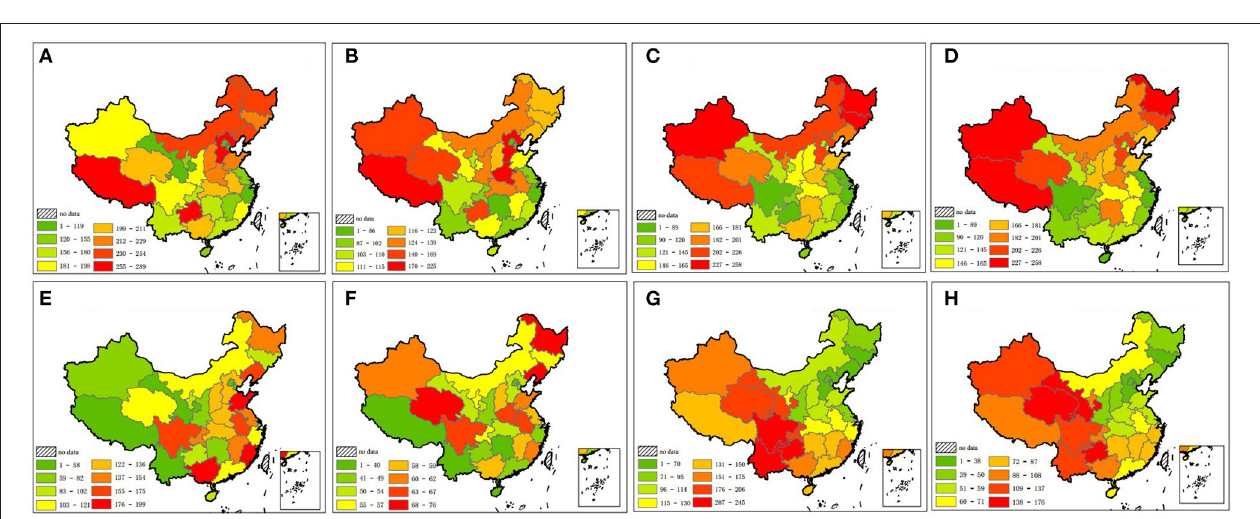
FIGURE 2 | Distribution of age-standardized mortality rates of four major fatal diseases. Warmer colors indicate a higher mortality rate. (A) Cerebrovascular disease in male. (B) Cerebrovascular disease in female. (C) Heart disease in male. (D) Heart disease in female. (E) Major tumors in male. (F) Major tumors in female. (G) Respiratory disease in male. (H) Respiratory disease in